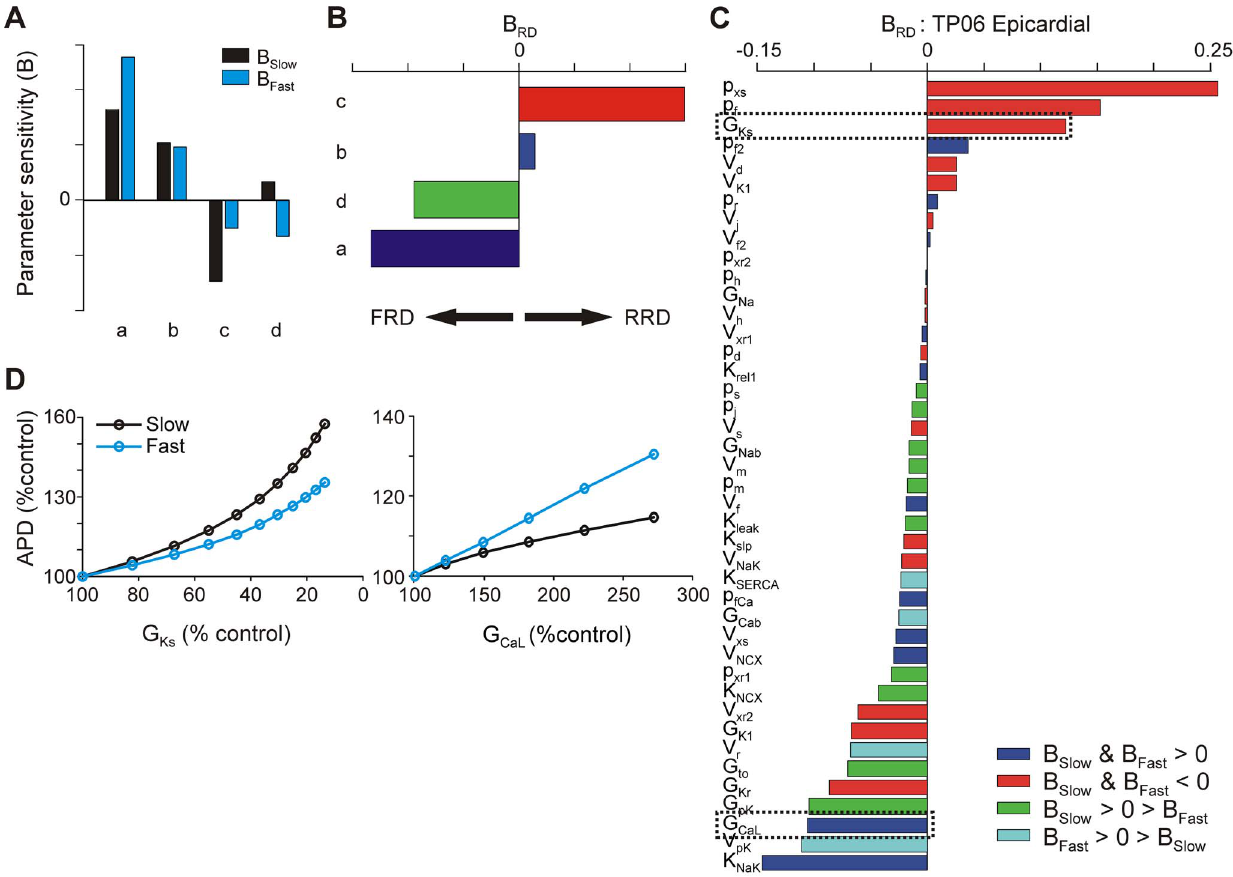
Figure 3. Action potential parameter sensitivity rate dependence. ( A ) Sensitivities ( B ) for hypothetical parameters a–d indicate how much each parameter influences the APD. Black bars represent that parameter’s influence at slow pacing, and blue bars its influence at fast pacing. ( B ) B RD is calculated from sensitivities B for each parameter in ( A ) as described in Methods . Positive B RD indicates a parameter that lengthens the APD with reverse-rate dependence (parameter c ), negative B RD indicates a parameter that lengthens the APD with forward rate dependence (parameters a and d ), and near-zero B RD indicates neutral rate dependence (parameter b ). ( C ) B RD for parameters in the TP06 model, derived from parameter sensitivities calculated from a population of 600 virtual myocytes. ( D ) Single perturbation simulation results for parameters G Ks and G CaL (slow delayed rectifier K + channel and L-type Ca 2 + channel conductance, respectively). Decreasing G Ks increases the APD with reverse rate dependence, and increasing G CaL increases the APD with forward rate dependence, as predicted by each parameter’s B RD